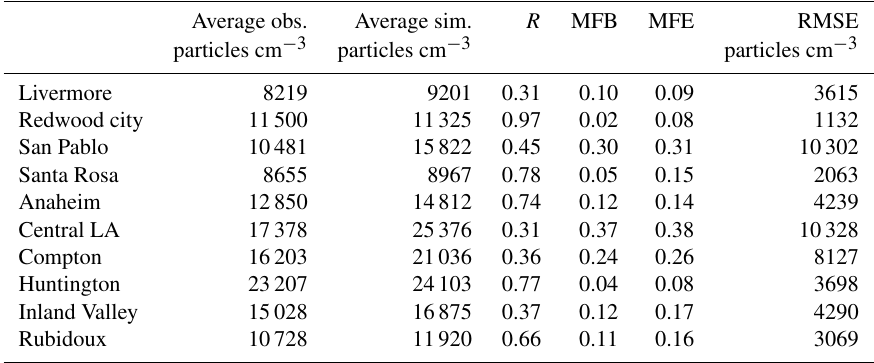
Table 1. Performance statistics for “best-fit” N 10 predictions vs. N 7 at individual monitoring sites. The threshold for PM modeling applica- tions is typically MFB< ± 0 . 5 and MFE<0.75. Average obs. Average sim. R MFB MFE RMSE particles cm − 3 particles cm − 3 particles cm − 3 Livermore